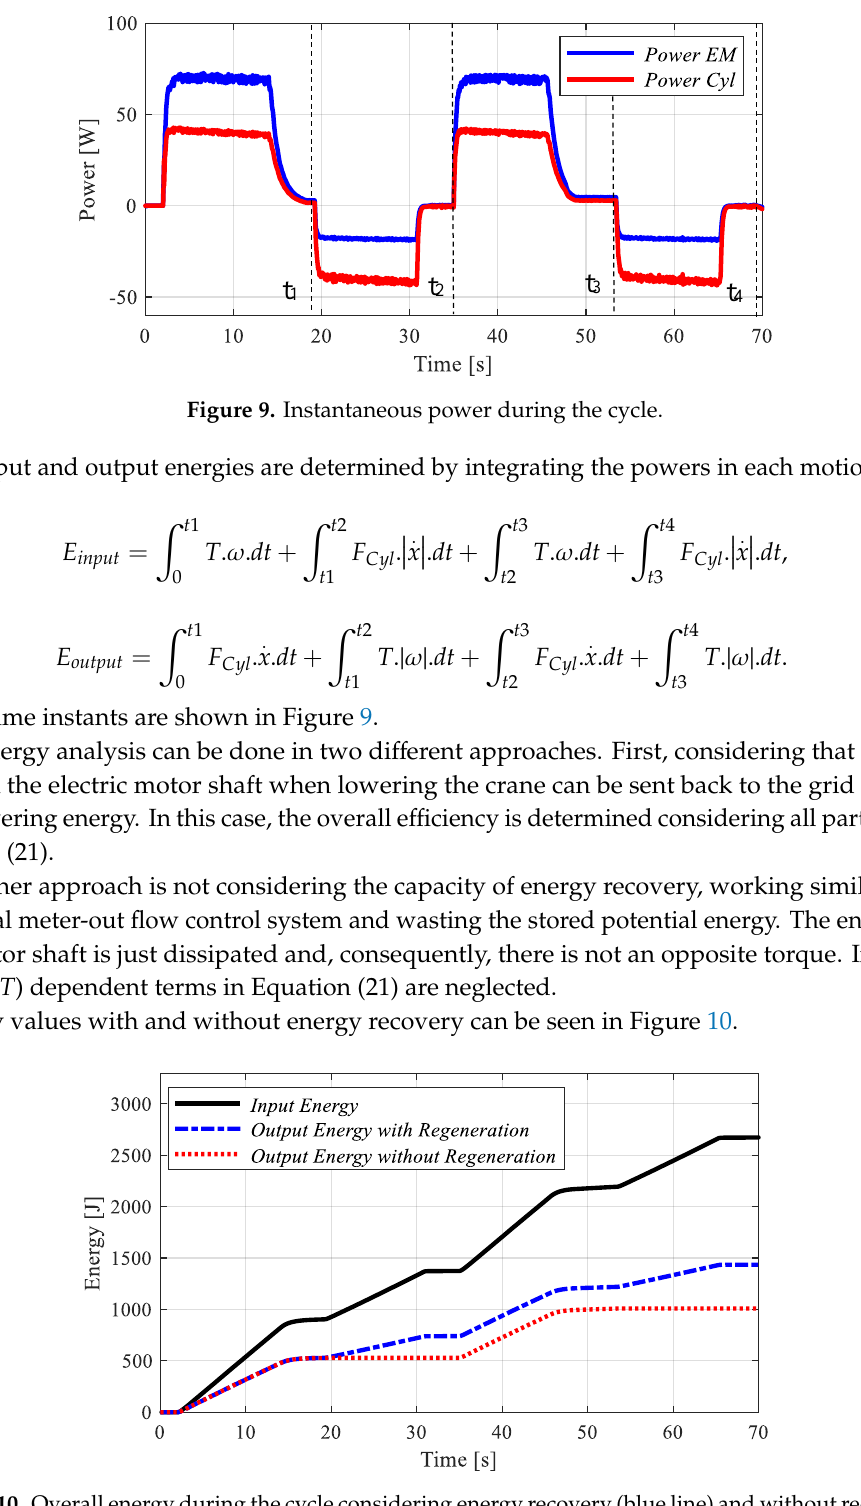
Figure 10. Overall energy during the cycle considering energy recovery (blue line) and without recovery (red line).